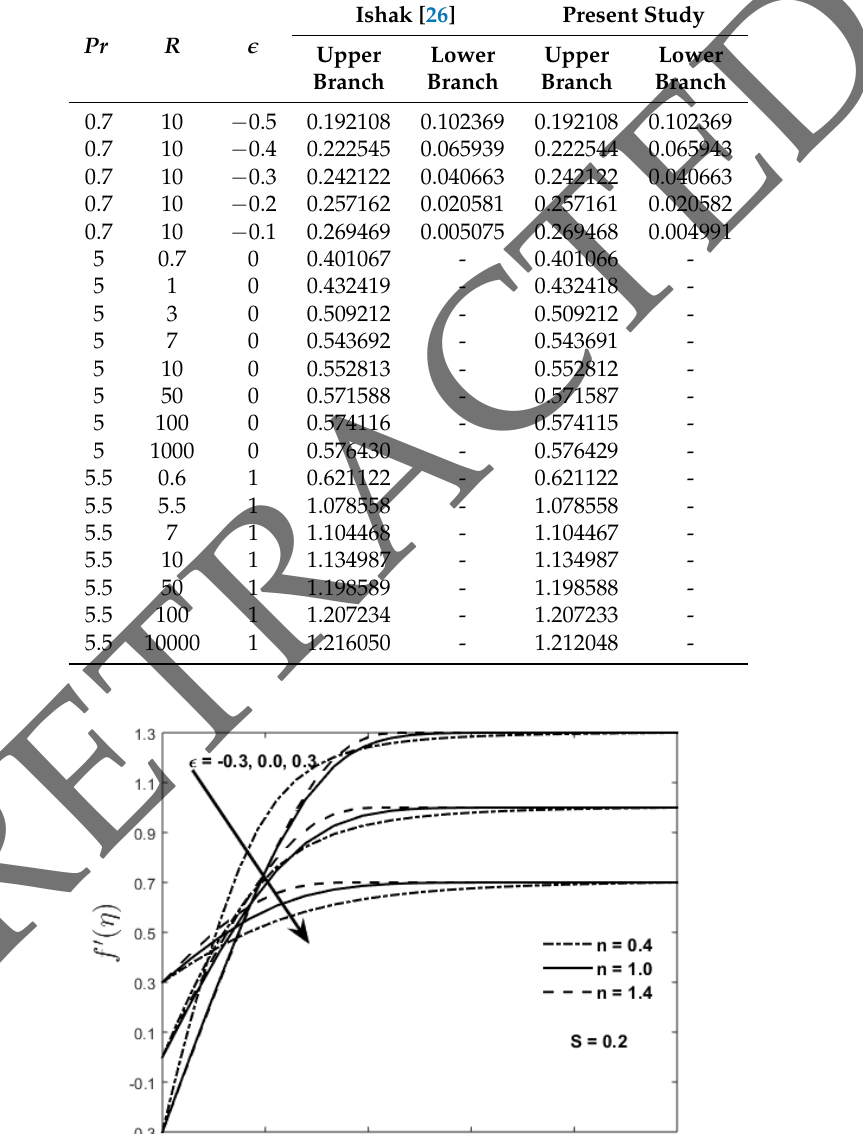
Table 2. A comparison of values of − θ (cid:48) ( 0 ) for various Pr , R and (cid:101) when n = 1, S = 0, Ec = 0, γ = 0, r = 0.